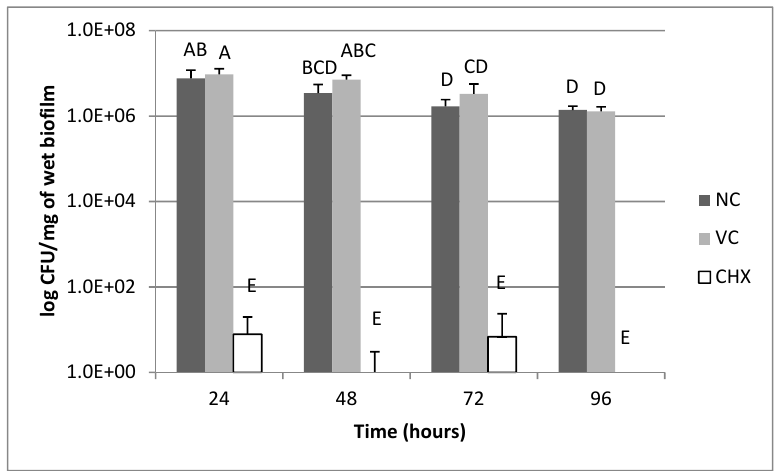
Figure 1. Bacterial viability of S. mutans biofilms according to treatments. NC= negative control (without exposure to formulation); VC= vehicle control; CHX= chlorhexidine-based chitosan formulation. Data expressed as mean ± standard deviation in logarithmic scale ( n = 6). Values that do not share the same letter (A, B, C, D, E) are significantly different from each other; Shapiro – Wilk test followed by Tukey – Kramer post-hoc test, p < 0.05.